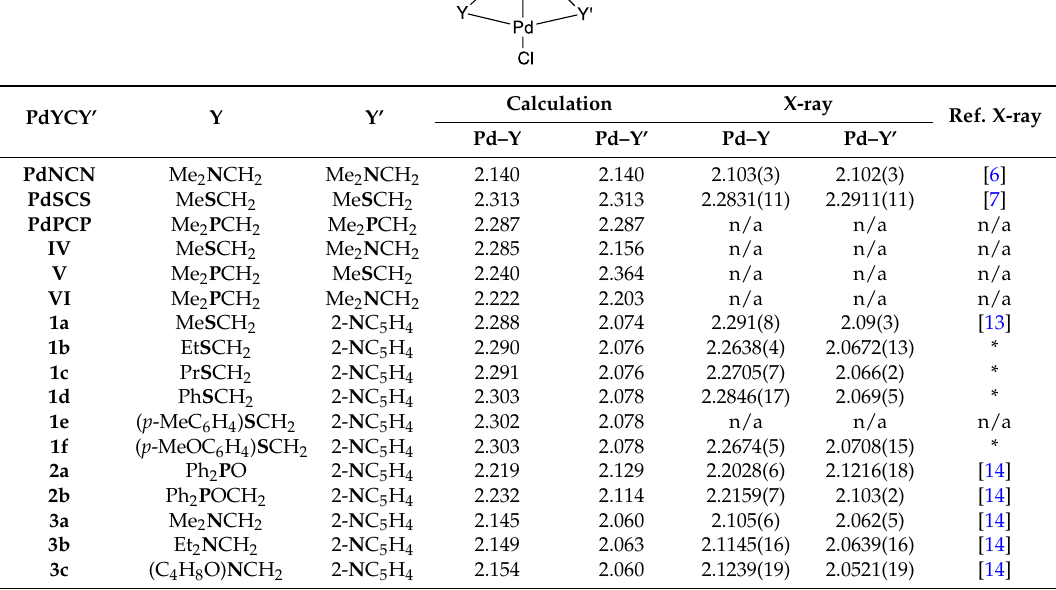
Table 4. Calculated and experimental Pd–Y and Pd–Y’ bond distances in symmetrical and unsymmetrical pincer palladacycles (bond distances are in Å). The donor atom is shown in bold for each side arm, Y and Y’.